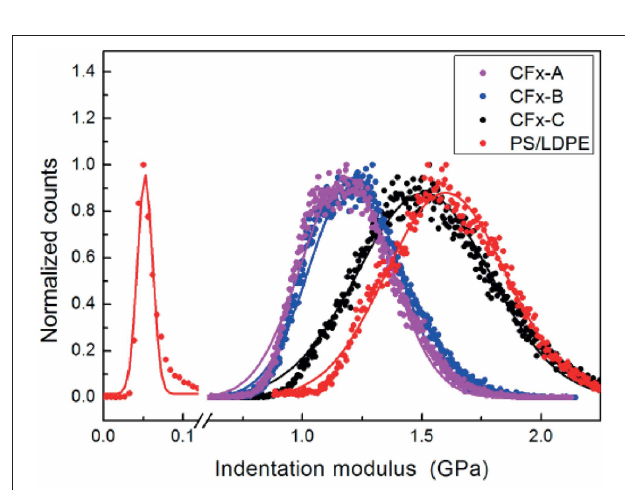
FIGURE 6 | Distribution of the values of indentation modulus of the three CF x samples and of the PS/LDPE reference, measured using HarmoniX TM